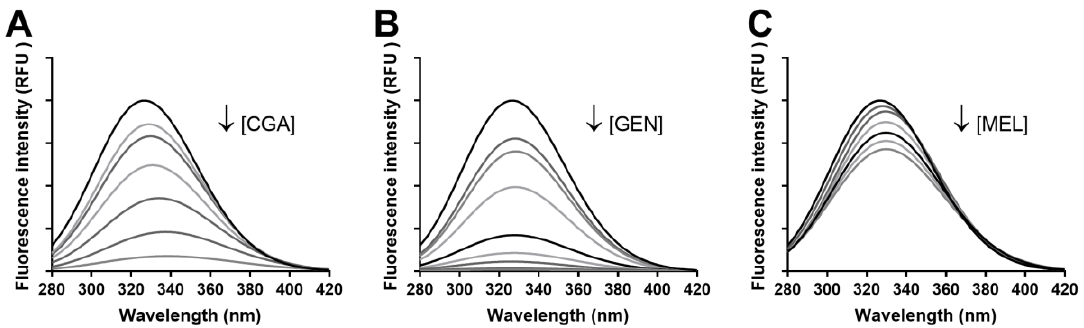
Figure 7. Fluorescence spectra of BSA showing fluorescence quenching in the absence and presence of varying concentrations of CGA (5–200 µmol L ‒1 ) ( A ), genistein (5–1000 µmol L ‒1 ) ( B ), and melatonin (5–200 µmol L ‒1 ) ( C ). λ ex = 250 nm, pH 7.4, T = 310 K.